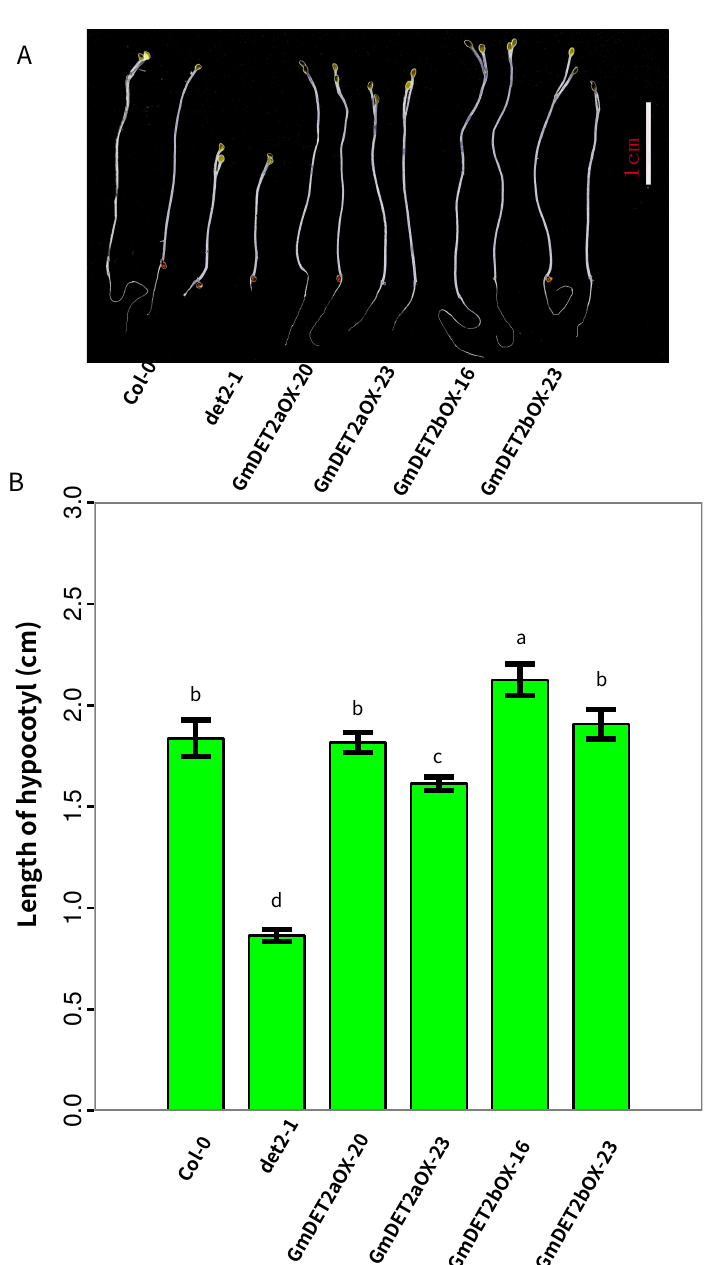
Figure 10. Ectopic expression of GmDET2a and GmDET2b rescued the skotomorphogenesis of Atdet2-1 . Seeds of Col-0, Atdet2-1 , transgenic lines were sown in half strength MS media and cultured in a growth chamber for one day with 16 h light/8 h dark cycle to promote germination. Seeds were then cultured in the dark for five days and photographed ( A ). Scale bar, 1 cm. The length of hypocotyls ( B ) was determined with ImageJ. Results are the means ± SD from four replicates with 10 samples, respectively. Different letters indicate significant differences at the 0.05 level (one-way